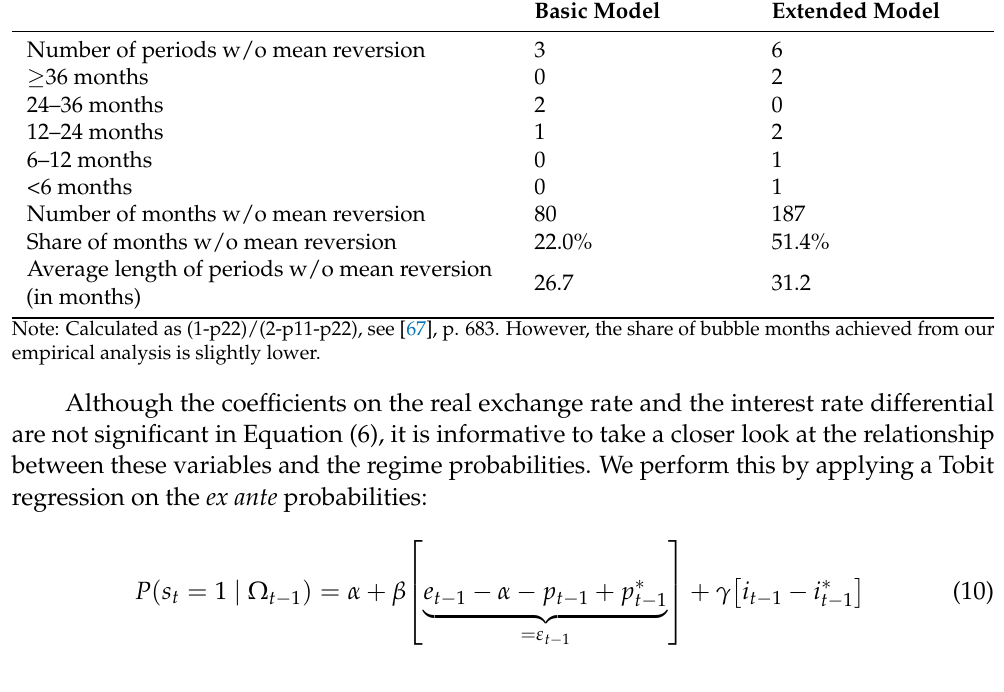
Figure 2. Real exchange rate and smoothed probability of being in the bubble regime (basic model). Table 4. Characteristics of bubbles. Basic Model Extended